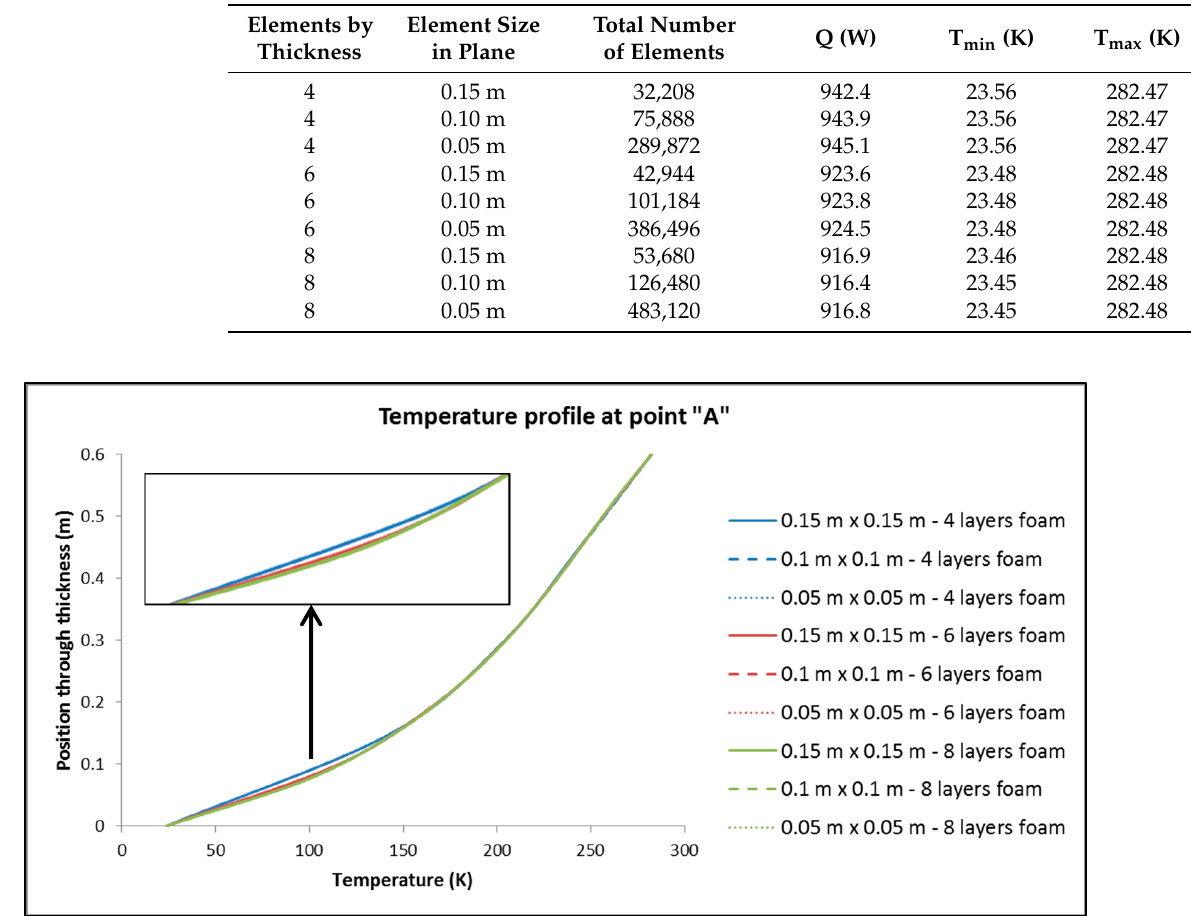
Figure 5. Points A, B, C of interest for temperature distribution calculation through the insulation thickness. Table 3. Output results for the selection of the mesh density. Table 3. Output results for the selection of the mesh density.